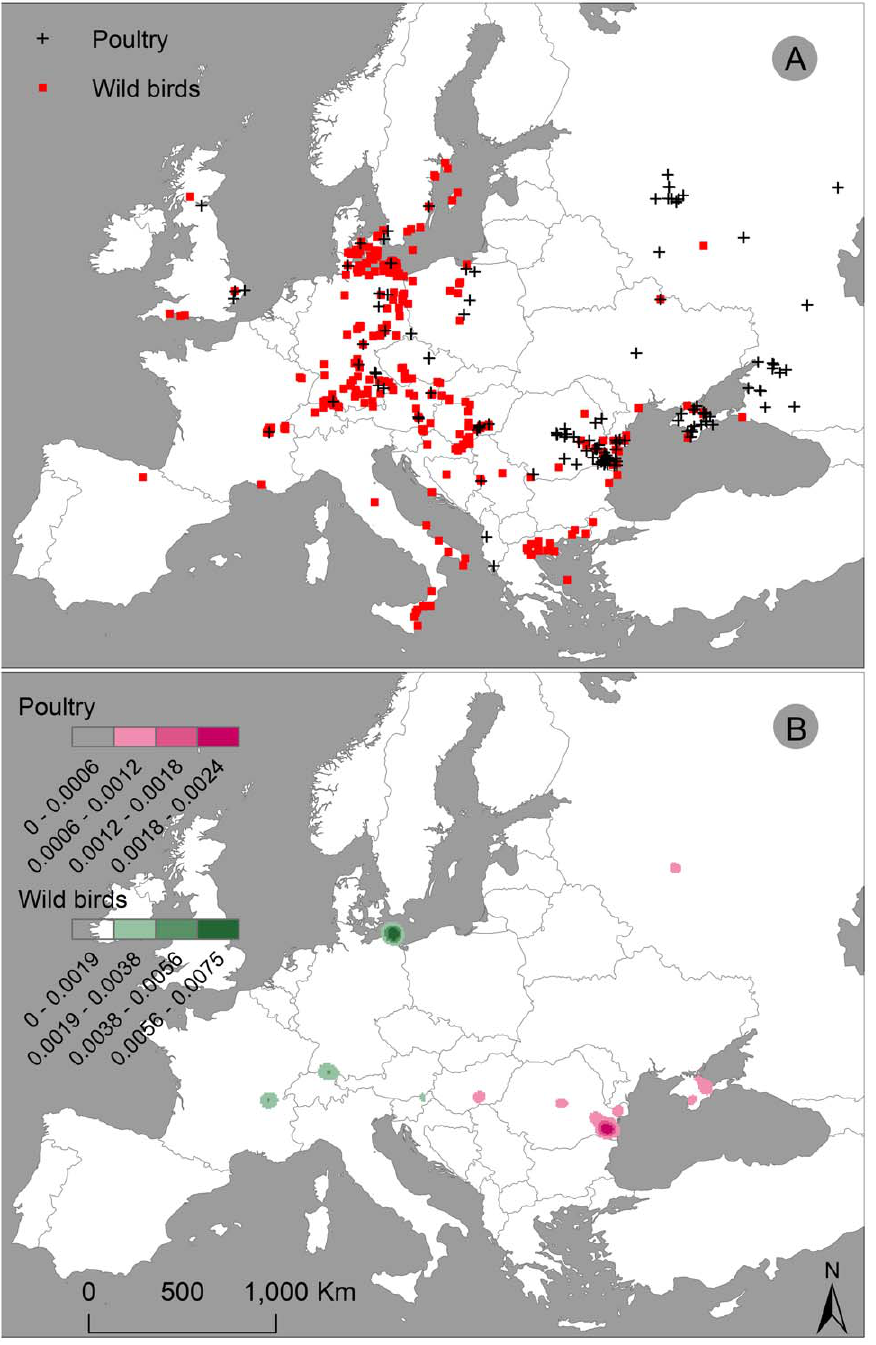
Figure 1. Distribution of confirmed highly pathogenic avian influenza (HPAI) H5N1 outbreaks in Europe from 2005 to 2008. (A) Outbreaks in poultry (red squares) and wild birds (black crosses). (B) Their kernel densities (number of outbreaks/square kilometre).